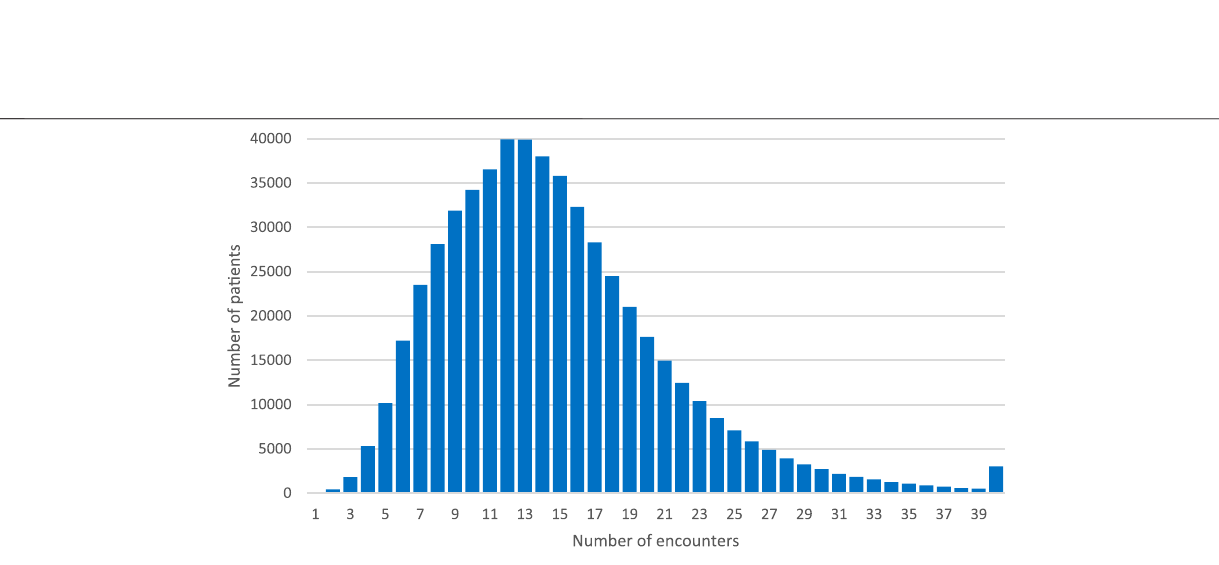
Frontiers in Pharmacology |